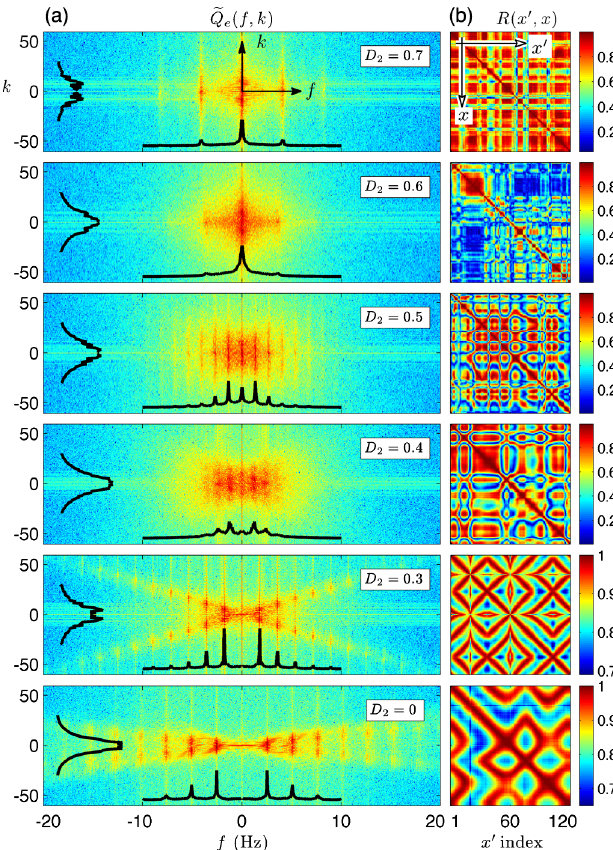
FIG. 6. Fourier spectra and phase coherence maps for the wake ~ Q f; k Þ shows the 2D discrete Fourier strip charts of Fig. 5. (a) e ð transform of Q e ð t; x Þ images of Fig. 5(b); f is the temporal frequency (Hz), and k is the spatial frequency in cycles =L x , where L x ¼ 25 cm is the x -axis side length of the cortical grid. Inset line graphs in black compare the average temporal spec- ~ Q f Þ (horizontal format: summed over wave number k ) trum e ð ~ Q k Þ (vertical format: against the average 1D spatial spectrum e ð summed over frequency f ). (b) Phase coherence maps R ð x; x 0 Þ showing the degree of firing-rate coherence for all time-series pairs Q e ð t; x Þ , Q e ð t; x 0 Þ along the y ¼ 60 midline of a 120 (cid:1) 120 cortical grid; coherence maps are computed from Hilbert transforms of the final 2 s (from t ¼ 18 to 20 s) of Fig. 5(b). The color bar shows the mapping between color and phase